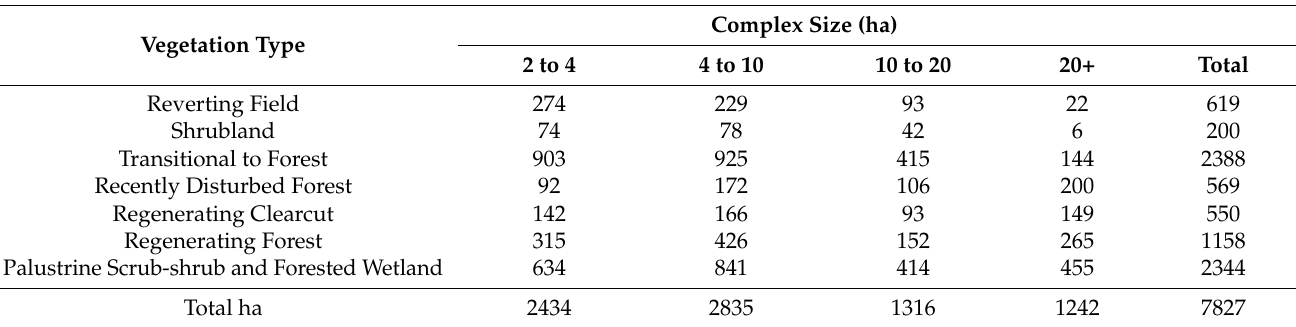
Table 6. Hectares of young forest and shrubland vegetation types by complex size for all New England Cottontail Focus Areas.